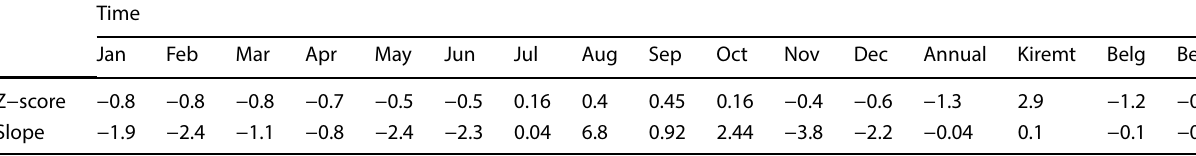
Table 9 MK test result of monthly and Seasonal discharge